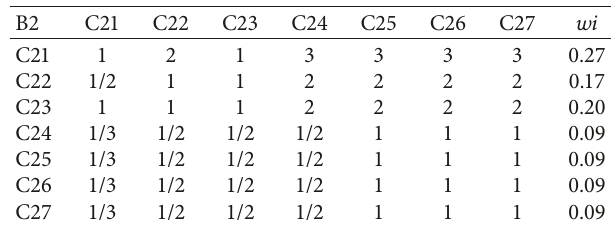
Table 8: Weights of indicators in b1-c and C layers of judgment matrix.